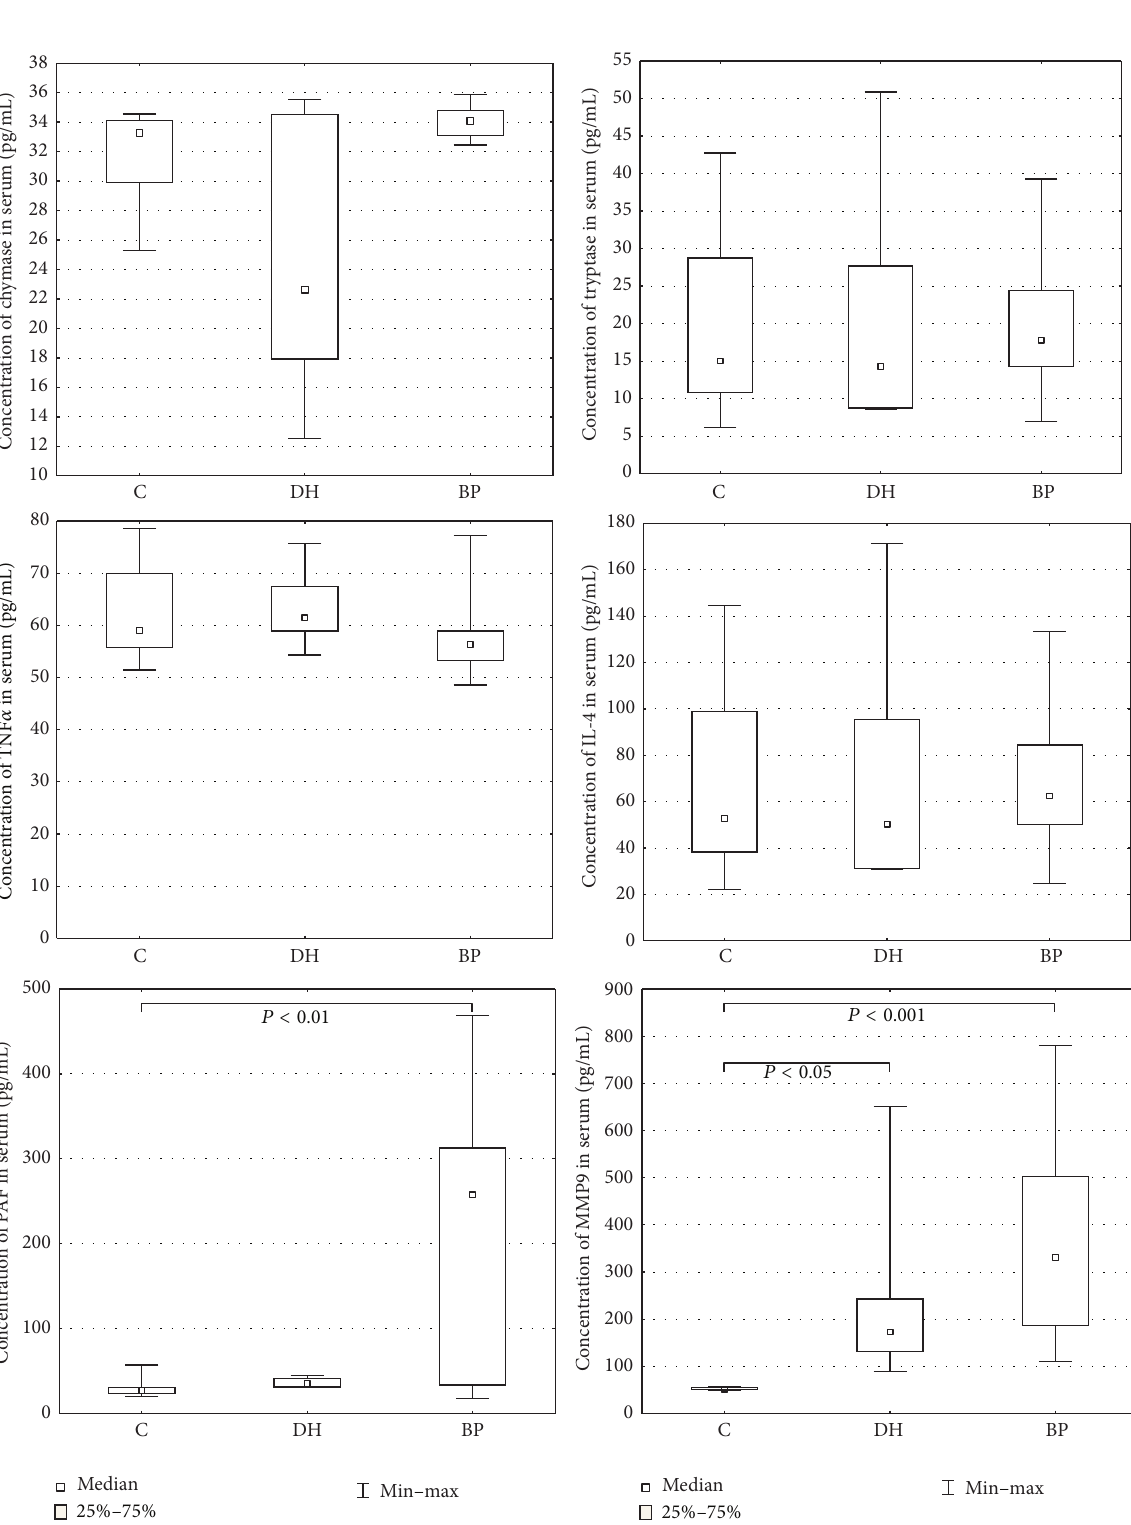
Figure 1: Serum levels of examined mediators in BP, DH, and control